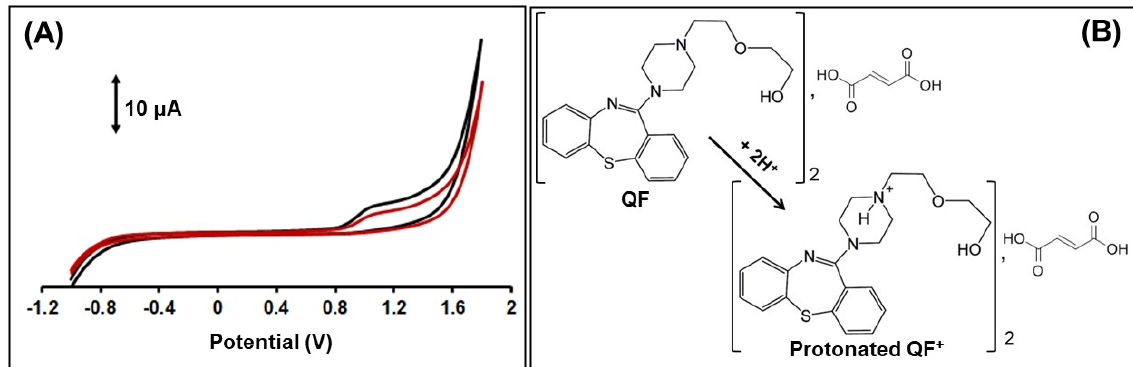
Figure 2. ( A ) CV responses of the 3D-printed device in the presence of 50 × 10 − 7 mol × L − 1 (red line) and 200 × 10 − 7 mol × L − 1 QF. Scan rate: scan rate, 50 mV × s − 1 ; electrolyte, 0.1 mol × L − 1 acetate buffer (pH 4.8). ( B ) Possible reaction of QF on the carbon black-loaded PLA WE.